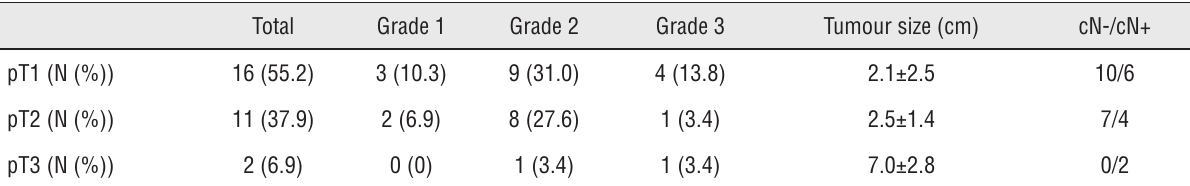
Table 2 - Clinical and pathological characteristics of primary tumour and clinical LN status of 29 patients diagnosed with penile cancer undergoing